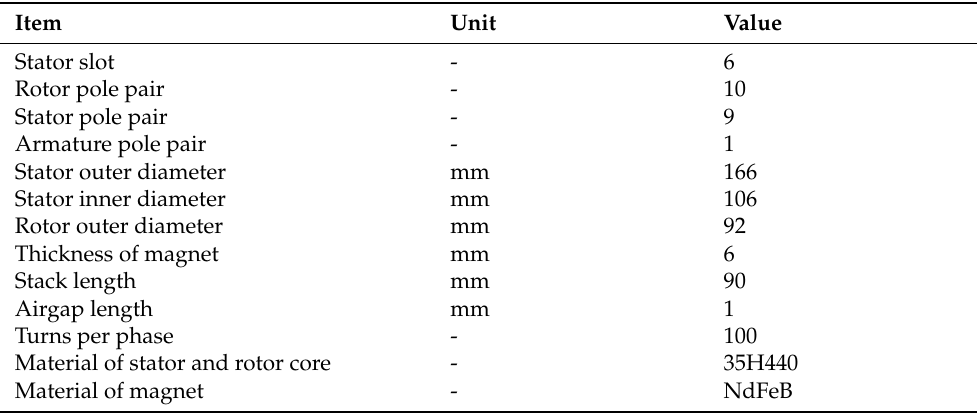
Table 3. Specification of the stator PM Vernier